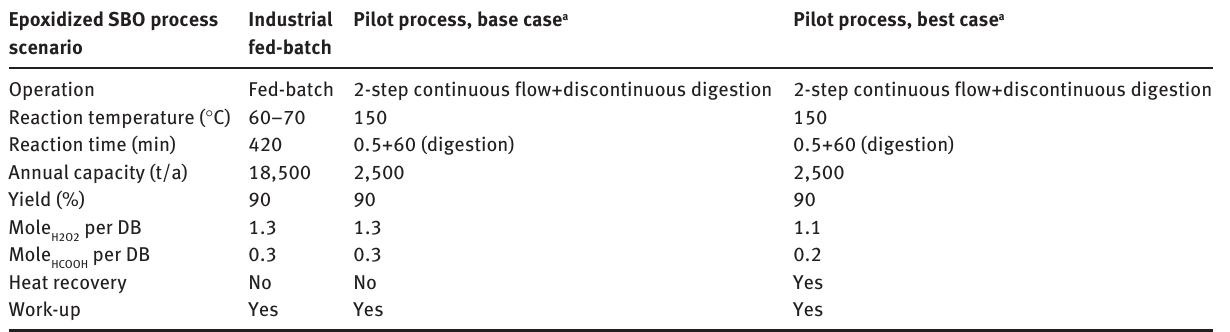
Table 3 Scenarios considered for environmental and cost efficiency evaluation of soybean oil (SBO) processing [9].